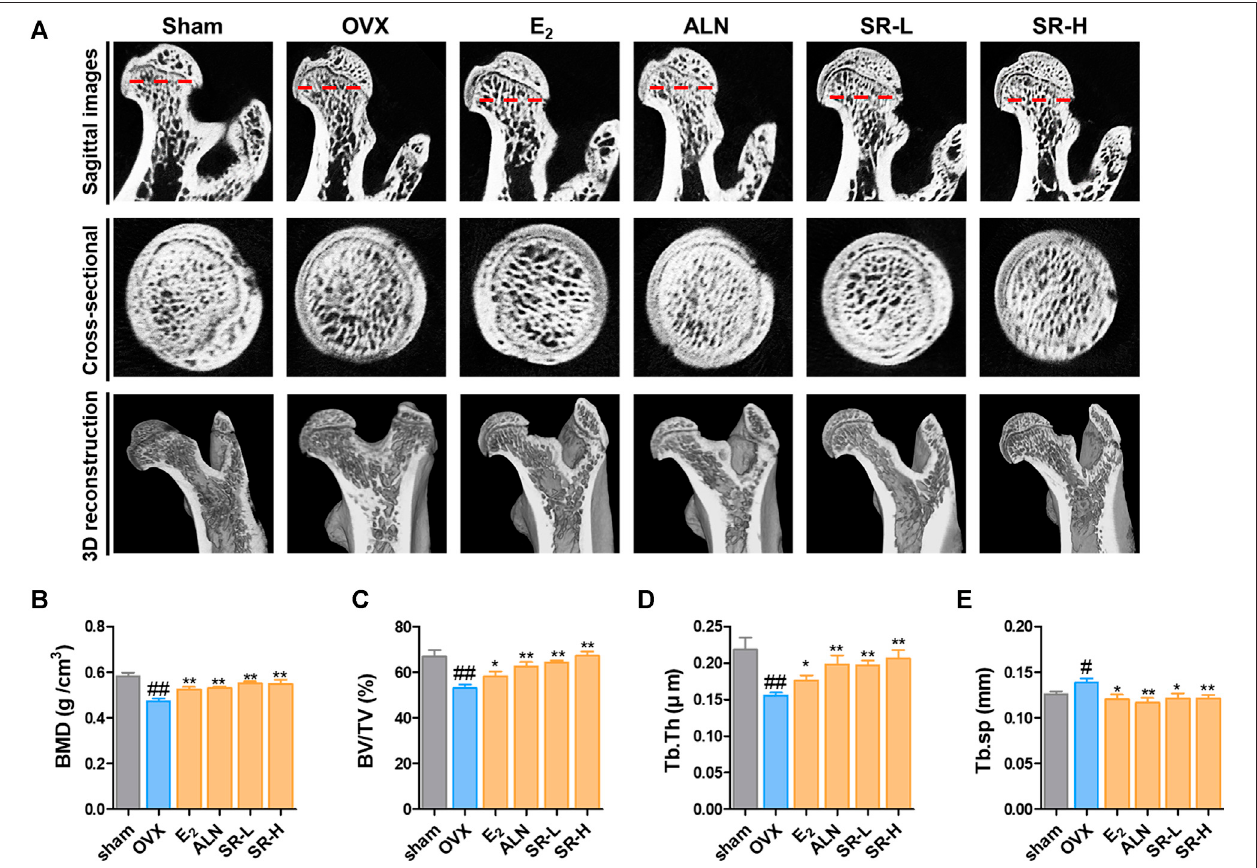
FIGURE 8 | Effects of SR on bone loss in the OVX-induced model. (A) Micro-CT analysis of the femurs. (B) BMD, (C) BV/TV, (D) Tb.Th and (E) Tb. sp of femurs were measured using micro-CT. The results are presented as the mean ± SEM of each experimental group ( n (cid:2) 8). Statistical analysis was performed using one-way ANOVAfollowedbyDunnett ’ sposthoctest. # p < 0.05, ## p < 0.01vs.thenormalgroup(sham-operationgroup);* p < 0.05,** p < 0.01vs.thecontrolgroup(OVX-induced